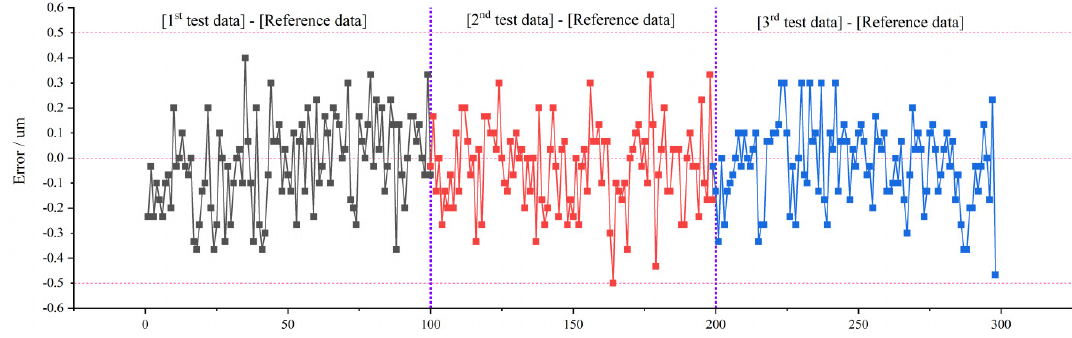
Figure 19. Measurement errors of blades.